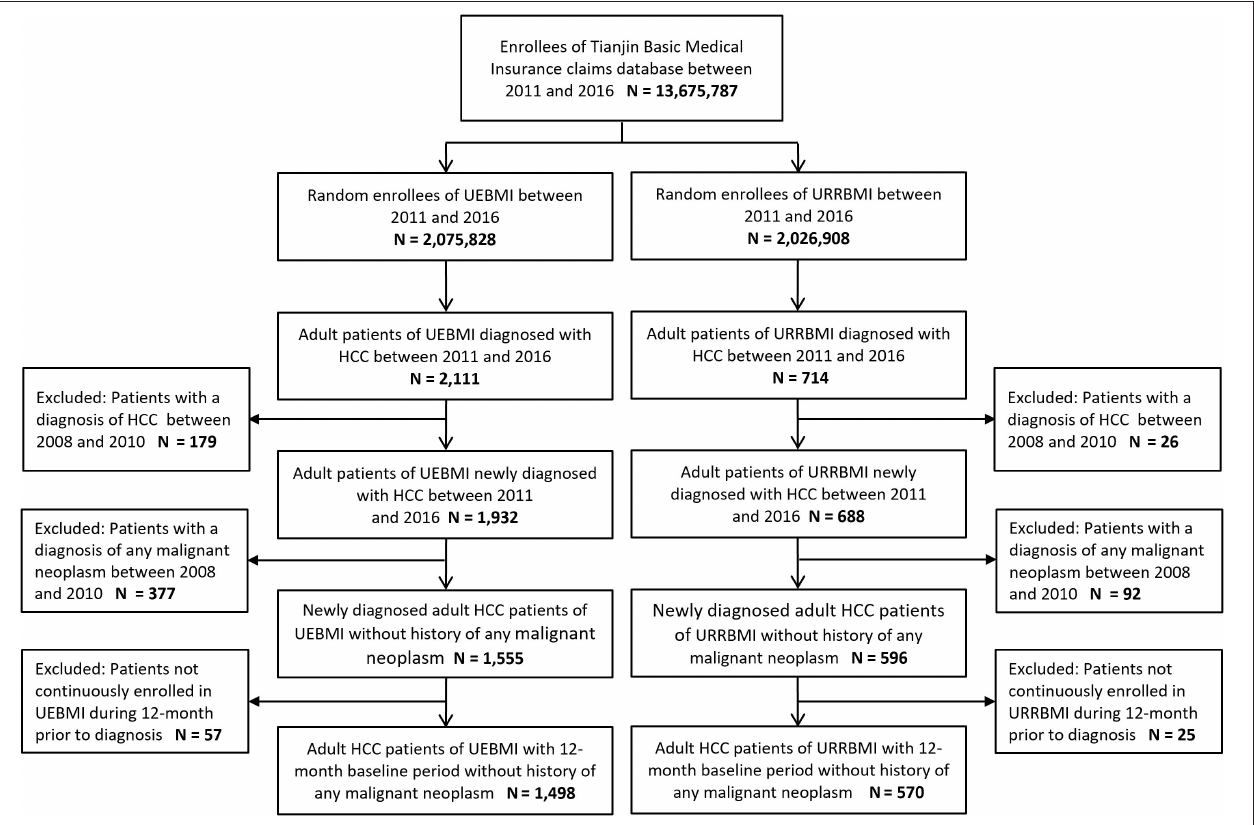
FIGURE 1 | Sample selection flowchart. UEBMI, Urban Employee Basic Medical Insurance; URRBMI, Urban and Rural Resident Basic Medical Insurance; HCC, hepatocellular